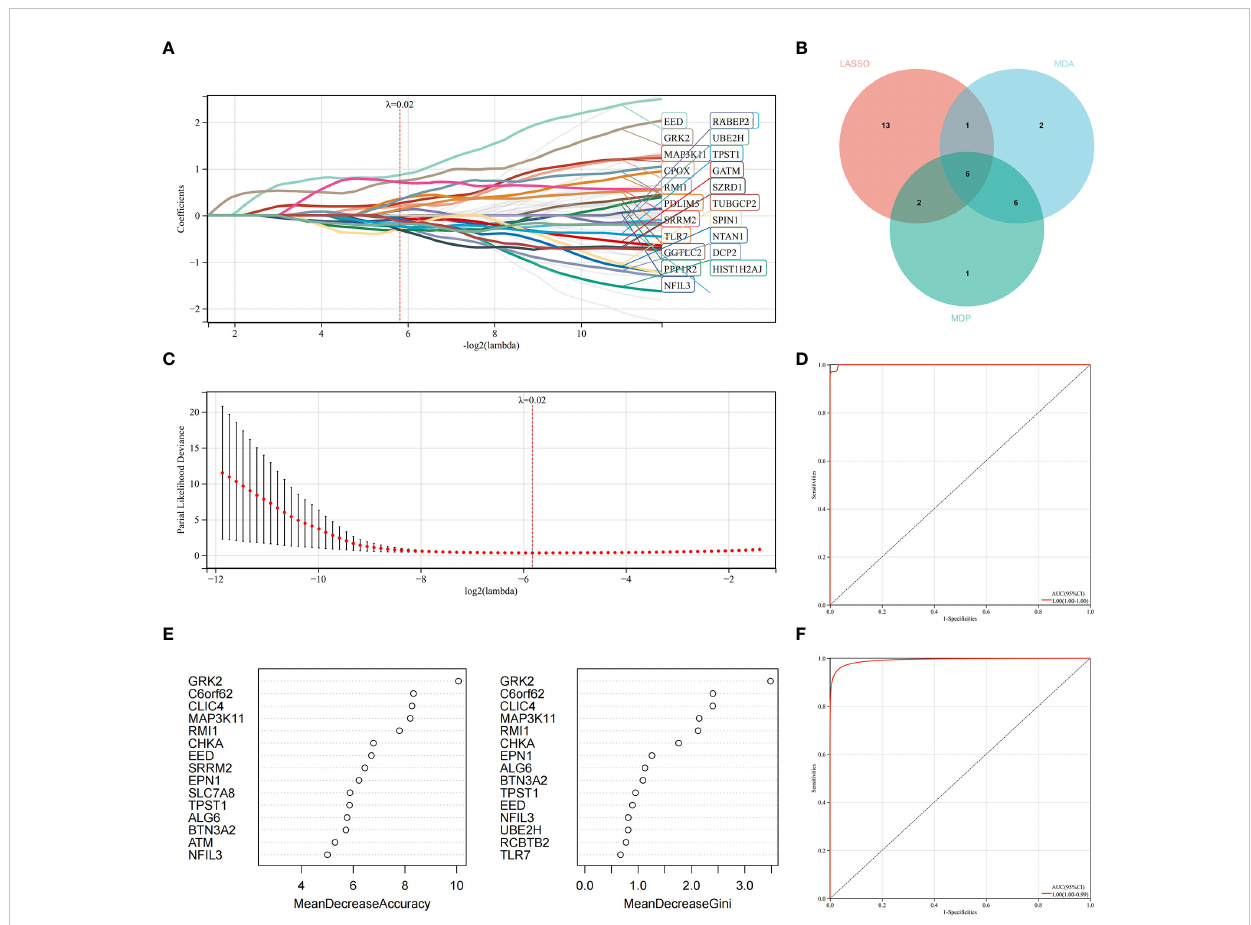
FIGURE 6 Machine learning in identifying key diagnosis genes for RA with AS. (A, B) Key genes identi fi ed in the LASSO model. Twenty-two genes are the most suitable for diagnosis. (C) The random forest algorithm ranks the top 15 most important genes based on MDA and MDP. (D) The intersection of genes of the above two algorithms is shown in the Venn diagram. (E) The ROC curve of the LASSO model. (F) The ROC curve of random forest